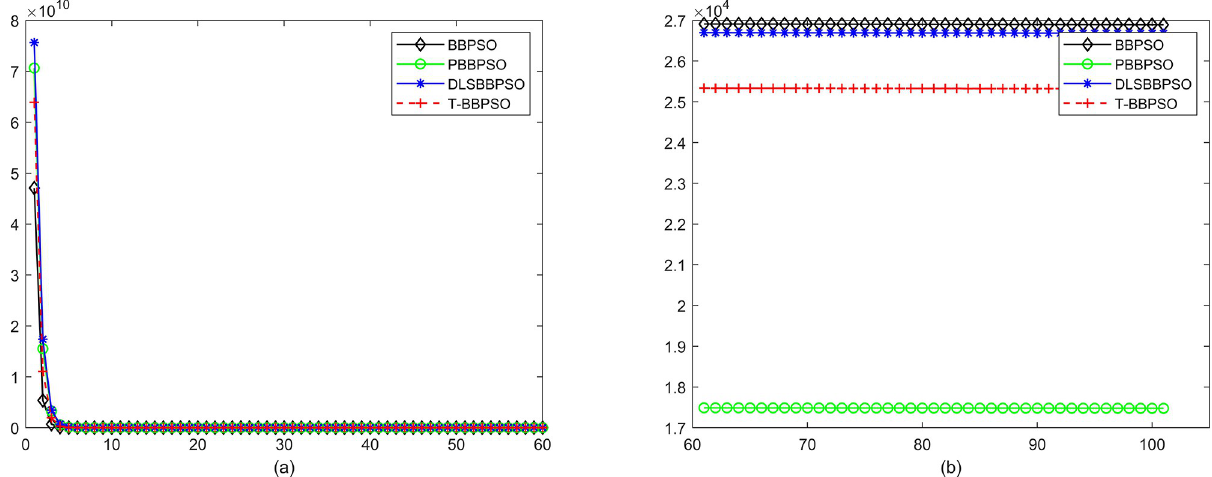
Fig 4. Comparison of convergence speed between BBPSO, PBBPSO, DLS-BBPSO and TBBPSO, f 2 , (a) iteration 0–6000, (b) iteration 6000–10000 the unit is 100 iteration.